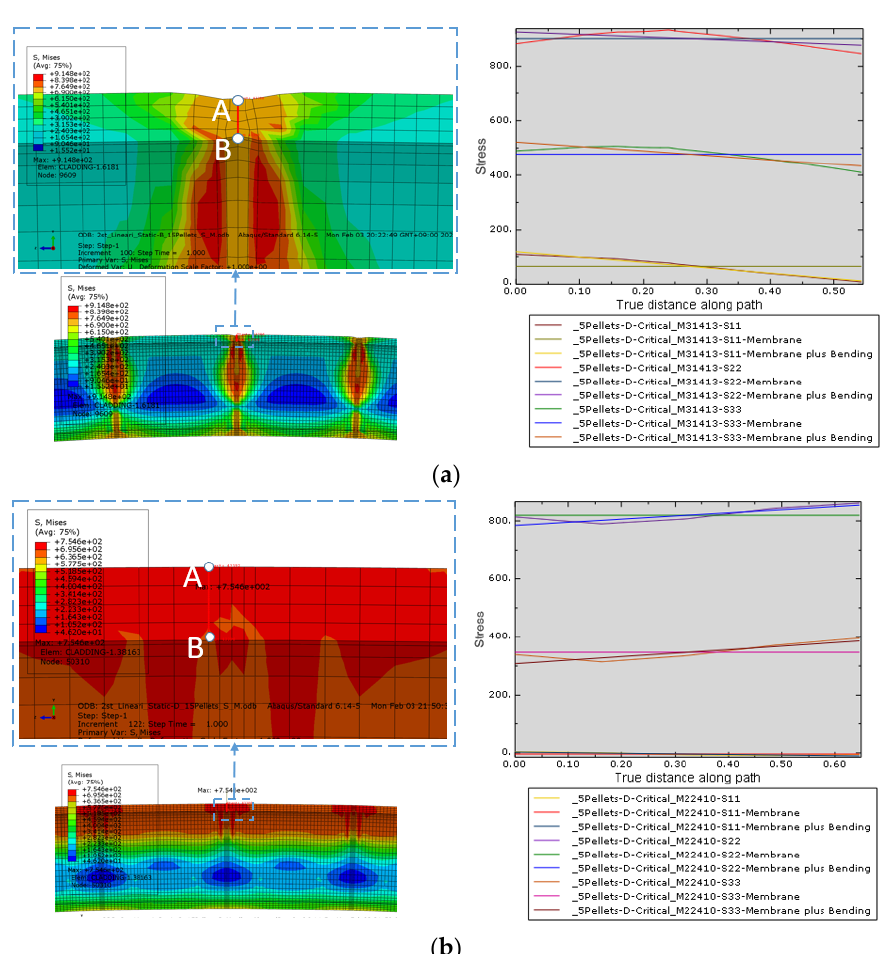
Figure 8. Stress linearization for the critical bending moment results of the detailed models: ( a ) stress linearization results of the fully bonded condition detailed model; ( b ) stress linearization results of the fully de-bonded condition detailed model.